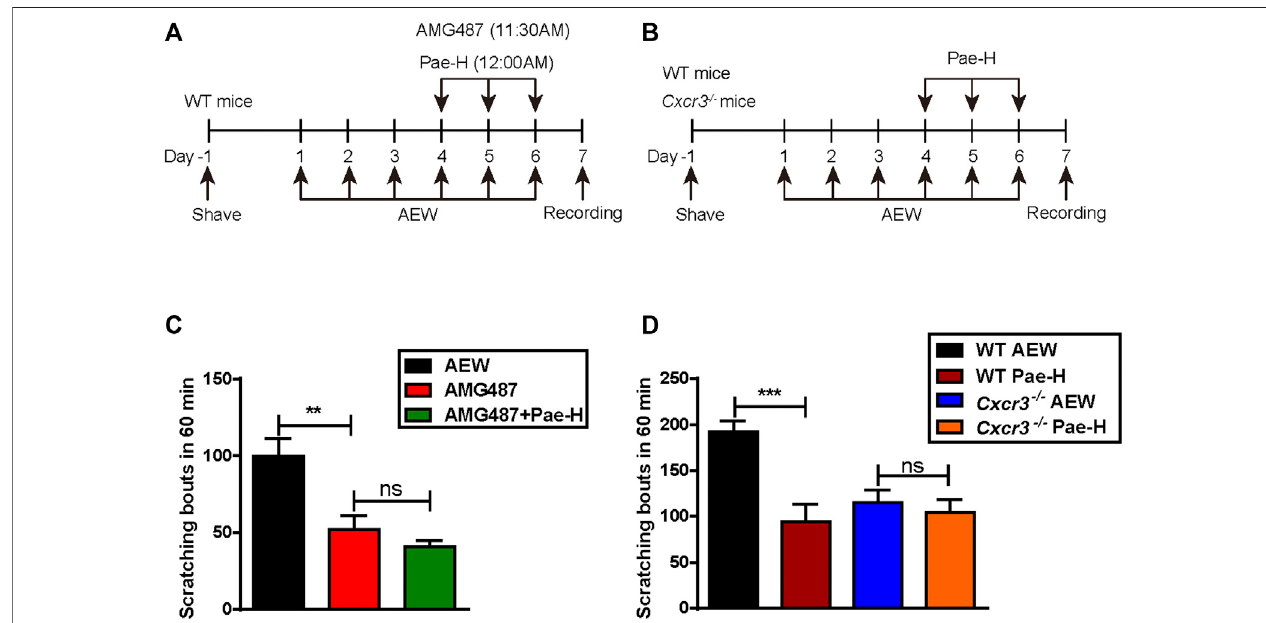
FIGURE 7 | The effects of paeonol on chronic itch in AMG487 pre-treated WT and Cxcr3 − / − mice. (A) Schematic protocol of CXCR3 inhibition and induction of AEW-induced dry skin model. (B) Schematic protocol of AEW-induced dry skin model in Cxcr3 − / − mice. (C) The effects of paeonol on AEW-induced spontaneous scratchinginWTmicepre-treated withAMG487. (D) Theeffects ofpaeonolonAEW-inducedspontaneousscratchingin Cxcr3 − / − mice( n (cid:1) 7 – 9each group).Datawere expressed as mean ± SEM. pp p < 0.01, ppp p < 0.001, compared to the WT-AEW model